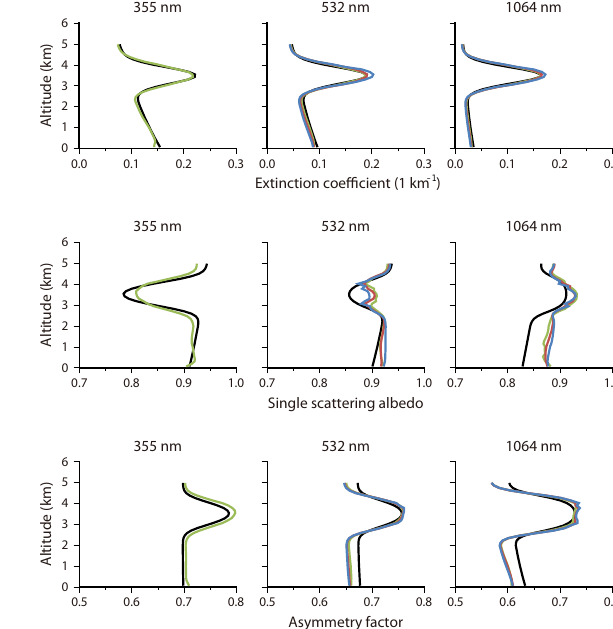
Figure 9. Retrieval results from the simulated data for the trans- ported dust: the extinction coefficients, the single-scattering albedo, and the asymmetry factor. “True” values are shown by the black lines, the colored lines indicate retrievals from Type 1 data set (MIEL data at 532 and 1064nm) (blue), Type 2 data set (MIEL data at 532 and 1064nm; HSRL data at 532nm) (red), and Type 3 data set (MIEL data at 532 and 1064nm; HSRL data at 355 and 532nm)